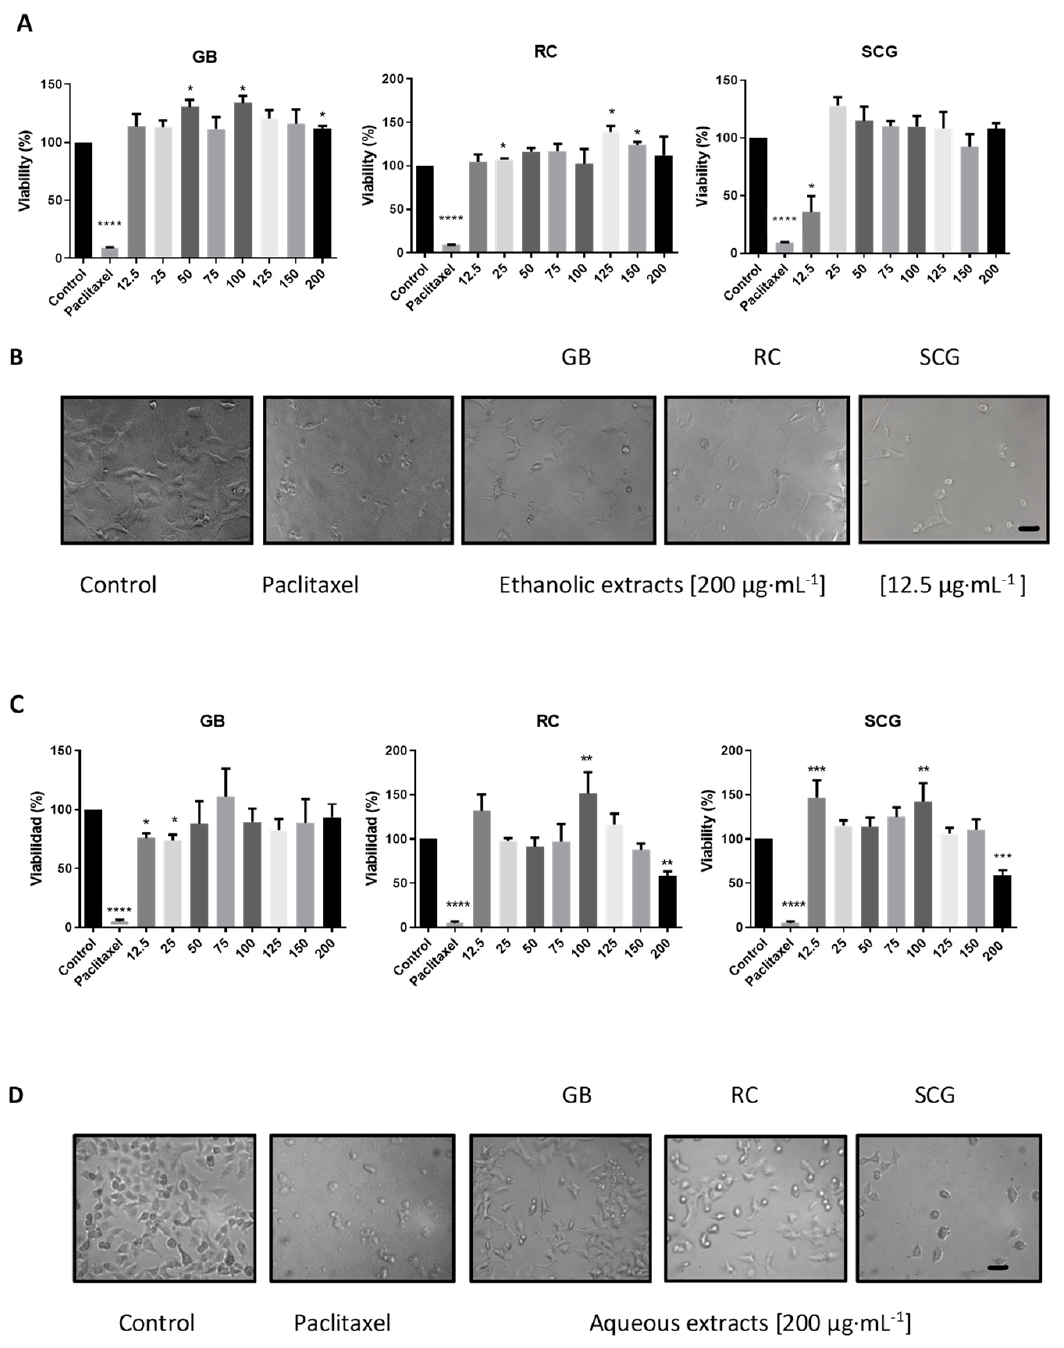
Figure 2. In vitro antiproliferative activity and morphological changes caused by ethanolic ( A , B ) and aqueous ( C , D ) extracts from GB, RC, and SCG in A549 cells. ( A ) Percentage of the viability of A549 cells, treated with different concentrations of ethanolic extracts, to evaluate the effect on cell proliferation. Green bean coffee, GB; roasted coffee, RC; spent coffee grounds, SCG; paclitaxel as a positive control (120 nM) during 24 h. ( B ) Morphological changes caused by coffee ethanolic extracts evaluated at 200 µ g · mL − 1 in GB and RC; the last photograph presents the cells exposed to SCG at 12.5 µ g · mL − 1 , a reduction in the number of cells compared with control and intracellular inclusions, such as apoptotic bodies, can be observed. ( C ) Percentage of viability of A549 cells treated with different concentrations of aqueous extracts, to evaluate the effect on cell proliferation. ( D ) Morphological changes caused by aqueous coffee extracts evaluated at 200 µ g · mL − 1 . Calibration bar, 50 µ m. Dunnett: ****, p < 0.0001; ***, p < 0.001; **, p < 0.01; and *, p < 0.05. In C33A cells, aqueous GB or ethanolic SCG extracts seemed to increase cell viability; however, this does not necessarily indicate an increase in cell proliferation. Similar results have been described, as some metabolites contained in GB or SCG coffee extracts can in ‐ crease enzymatic ‐ mitochondrial activity, specifically a phytochemicals such as kahweol and cafestol, and CGAs can increase and potentiate mitochondrial ‐ reducing enzymes and increased formazan products, which can result in higher percentages of cell viability [39]. Notably, the ethanolic extract from SCG diminished A549 cell viability only at 12.5 μ g ∙ mL − 1 , the lowest concentration evaluated. These results can be explained by the bipha ‐ sic dose ‐ response or hormesis, with a stimulatory effect at a low concentration, while high